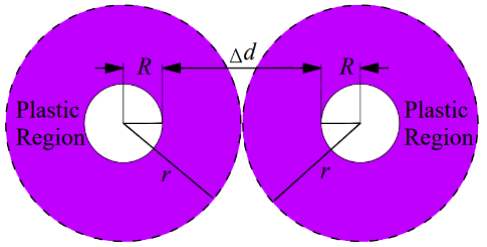
Figure 16. Plastic tangent diagram of two boreholes. In summary, construction drilling can unload the high stress in the rock mass and reduce the elastic strain energy stored in the rock mass, thereby achieving the effect of pressure relief. The larger the radius and depth of the borehole, the larger the radius of the plastic zone of the rock mass, and the smaller the strength of the rock mass and the cumulative elastic strain energy, the more the peak stress is transferred to the deep part, and the better the pressure relief effect, which is in line with the test conclusions of 2.1 and 2.2 in the text. When the drilling spacing Δ d ≤ 3.286 cm, the plastic zone formed by the two boreholes is connected, the peak strength changes the most, and the pressure relief effect is obvious. The results are in line with the experimental conclusions of 2.3 and 3.3. The stress state around the hole is changed after the rock mass is drilled, which is the main reason for the tensile failure or shear failure of the rock mass. Therefore, it is partic ‐ ularly important to study the stress state around the borehole and then judge its failure mode. According to the stress distribution formula at the edge of the hole [28]: